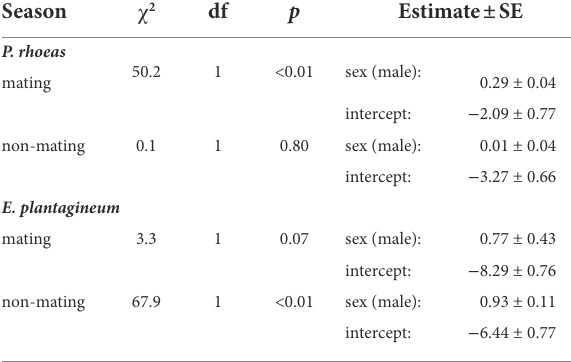
TABLE 4 Results of generalized linear mixed models (GLMMs) of dry weight proportion of Papaver rhoeas and Echium plantagineum in great bustard fecal droppings in central Spain in each season.